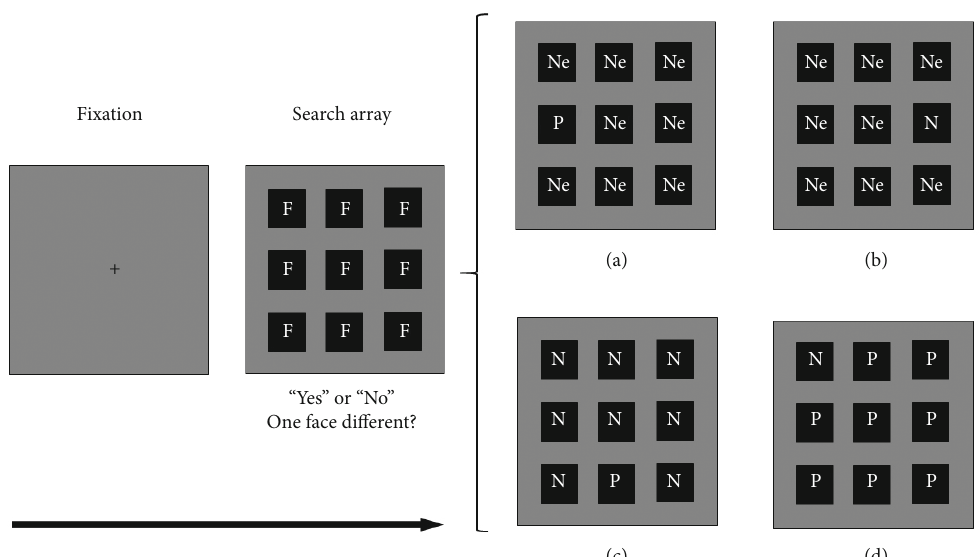
Figure 1: Illustration of a visual search paradigm. Participants needed to detect whether one face di ff ered from the other faces. The letter F denotes a face in the search array. Usually, in half of the trials, all faces show the same expression, while in the other half of the trials, one face shows a di ff erent expression from the other faces. The trials containing di ff erent kinds of expressions (as presented in panels (a) – (d)) have usually occurred in four versions: (a) one positive face with a neutral face background (P: positive face; Ne: neutral face); (b) one negative face with a neutral face background (N: negative face; Ne: neutral face); (c) one positive face with a negative background (P: positive face; N: negative face); (d) one negative face with a positive background (N: negative face; P: positive face). Note that the set size in each search array can di ff er across studies. Negative face: angry, fearful, sad, or disgusted expression face; positive face: happy expression face; neutral face: neutral expression